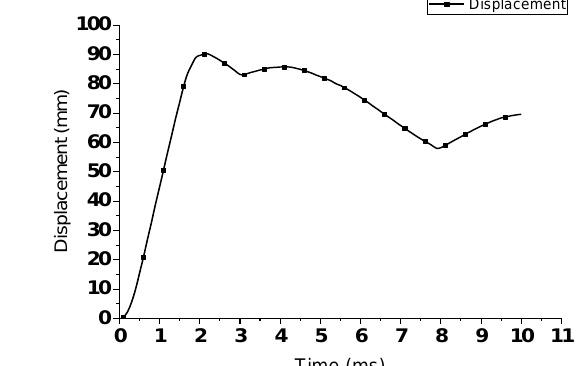
( b ) Displacement time history with the mitigation system Figure 22. The displacement response.